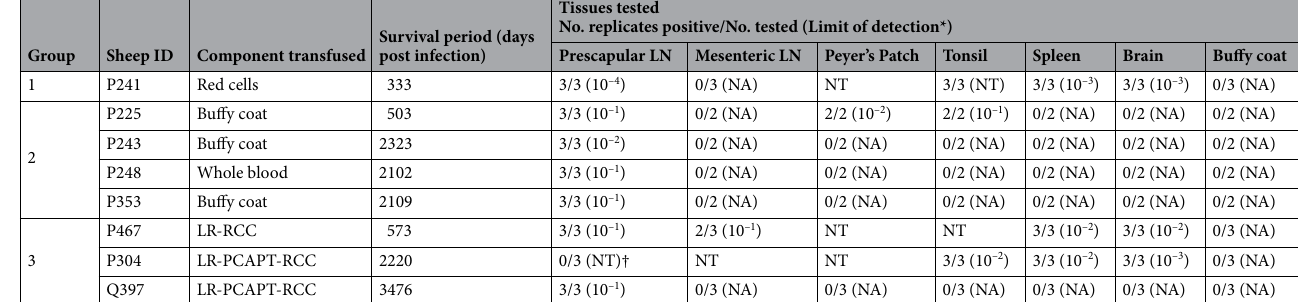
Table 2. PMCA results and limit of detection in tissues from selected sheep with positive PMCA in PSLN. NA not applicable, NT not tested. *Highest dilution of tissue homogenate giving positive PMCA result. † Positive in several other experiments for 10 –1 dilution (see Table